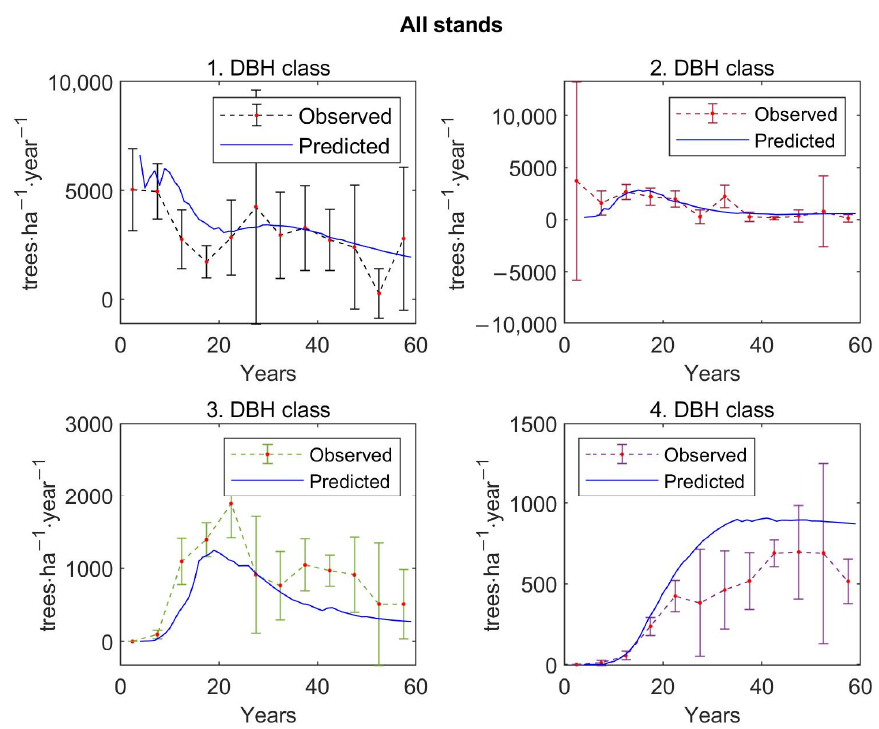
Figure 6. Verification of the model by the comparison of the observed 5-year average values with average predicted values of stem density distributed according to DBH classes, with a 95% confidence interval, over 250 inventory plots.